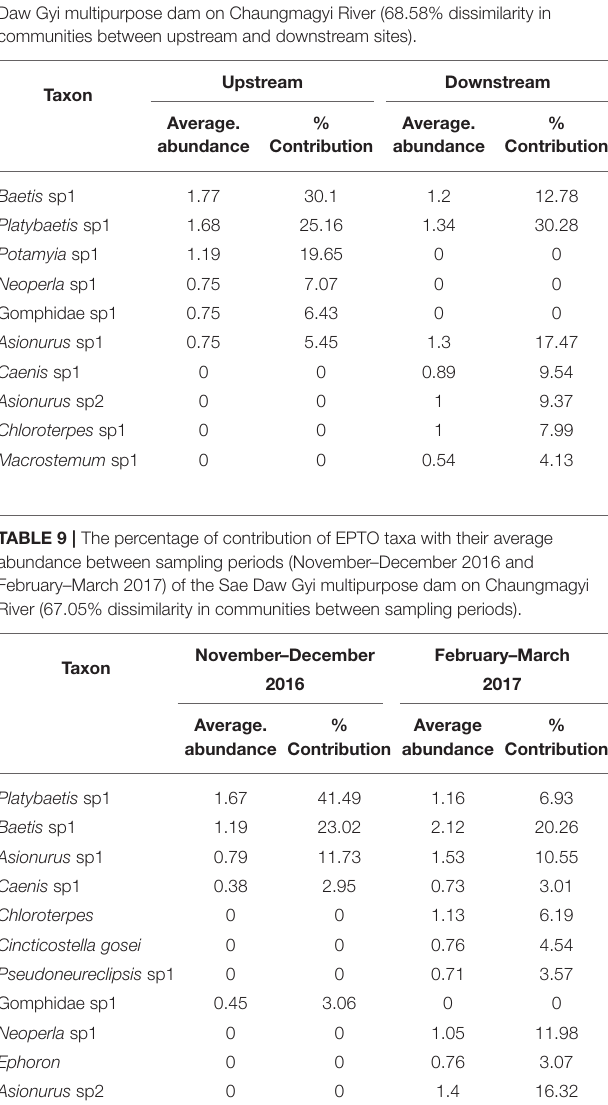
TABLE 8 | The percentage of contribution of EPTO taxa with their average abundance between sampling locations (upstream and downstream) of the Sae